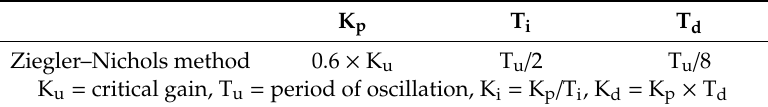
Table 1. Control parameters of the Ziegler–Nichols method.